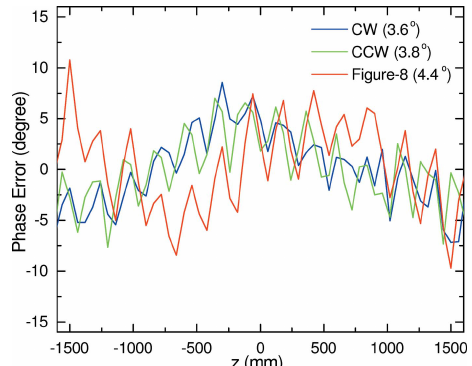
Figure 9 Phase errors evaluated from the measured field distributions for the three operation